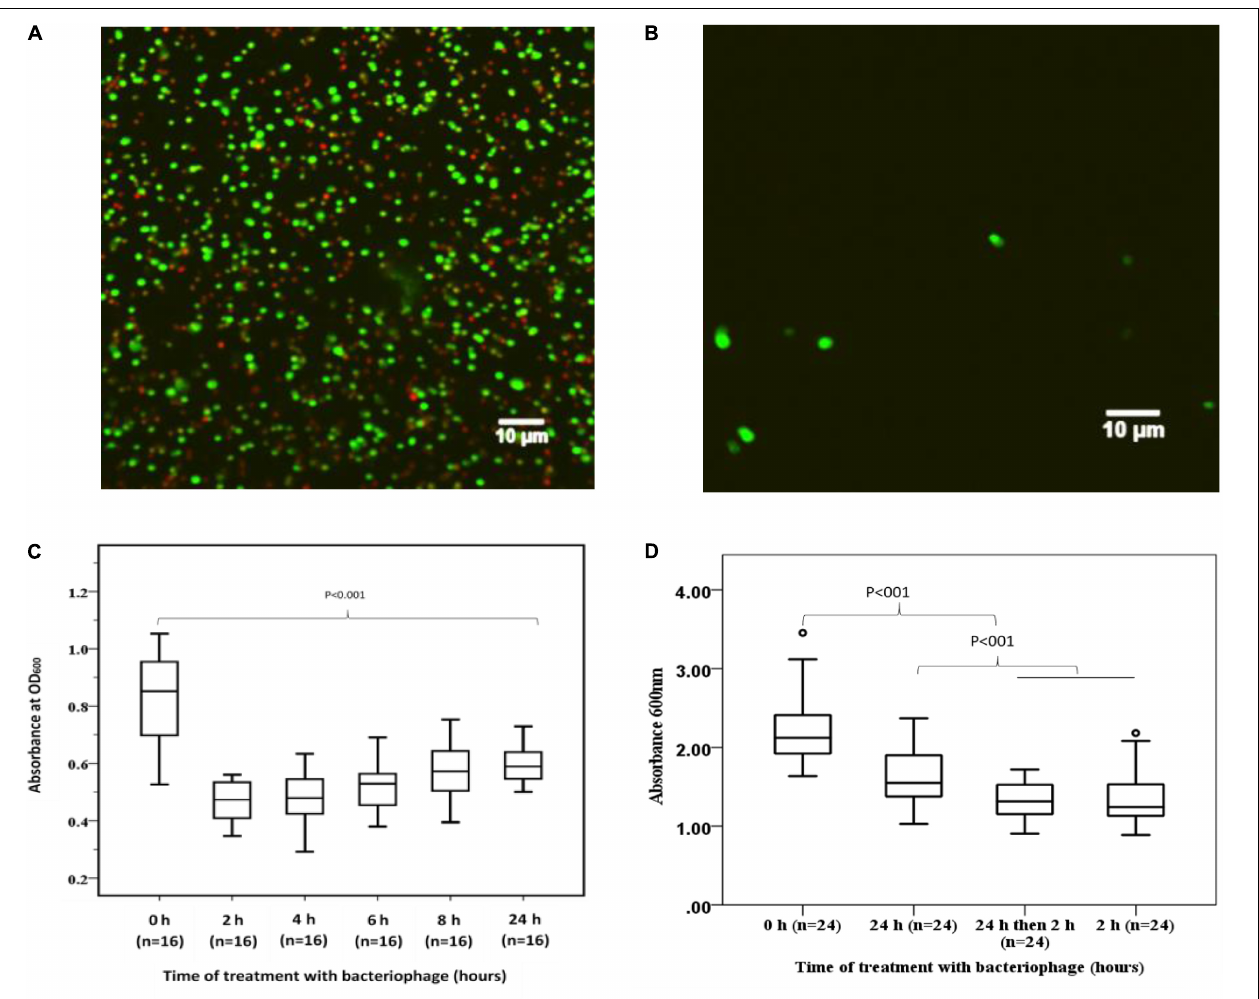
FIGURE 5 | Effects of EFA1 bacteriophage on E. faecalis biofilm viability and mass. (A) Untreated E. faecalis biofilm showing bacteria attached to slide were predominantly membrane intact cells (green), with some bacteria with leaky membranes (red/brown). (B) Bacteriophage EFA1 treated biofilm with scant cells remaining attached to slide. (C) Quantification of biofilm at time 0 h (without EFA1 treatment) is significanlty greater than any other biofilm treated with bacteriophage EFA1. The lowest amount of biofilm mass was seen after 2 h treatment. Biofilm mass steadly increased with exposure to EFA1. (D) 5 days biofilm treated with